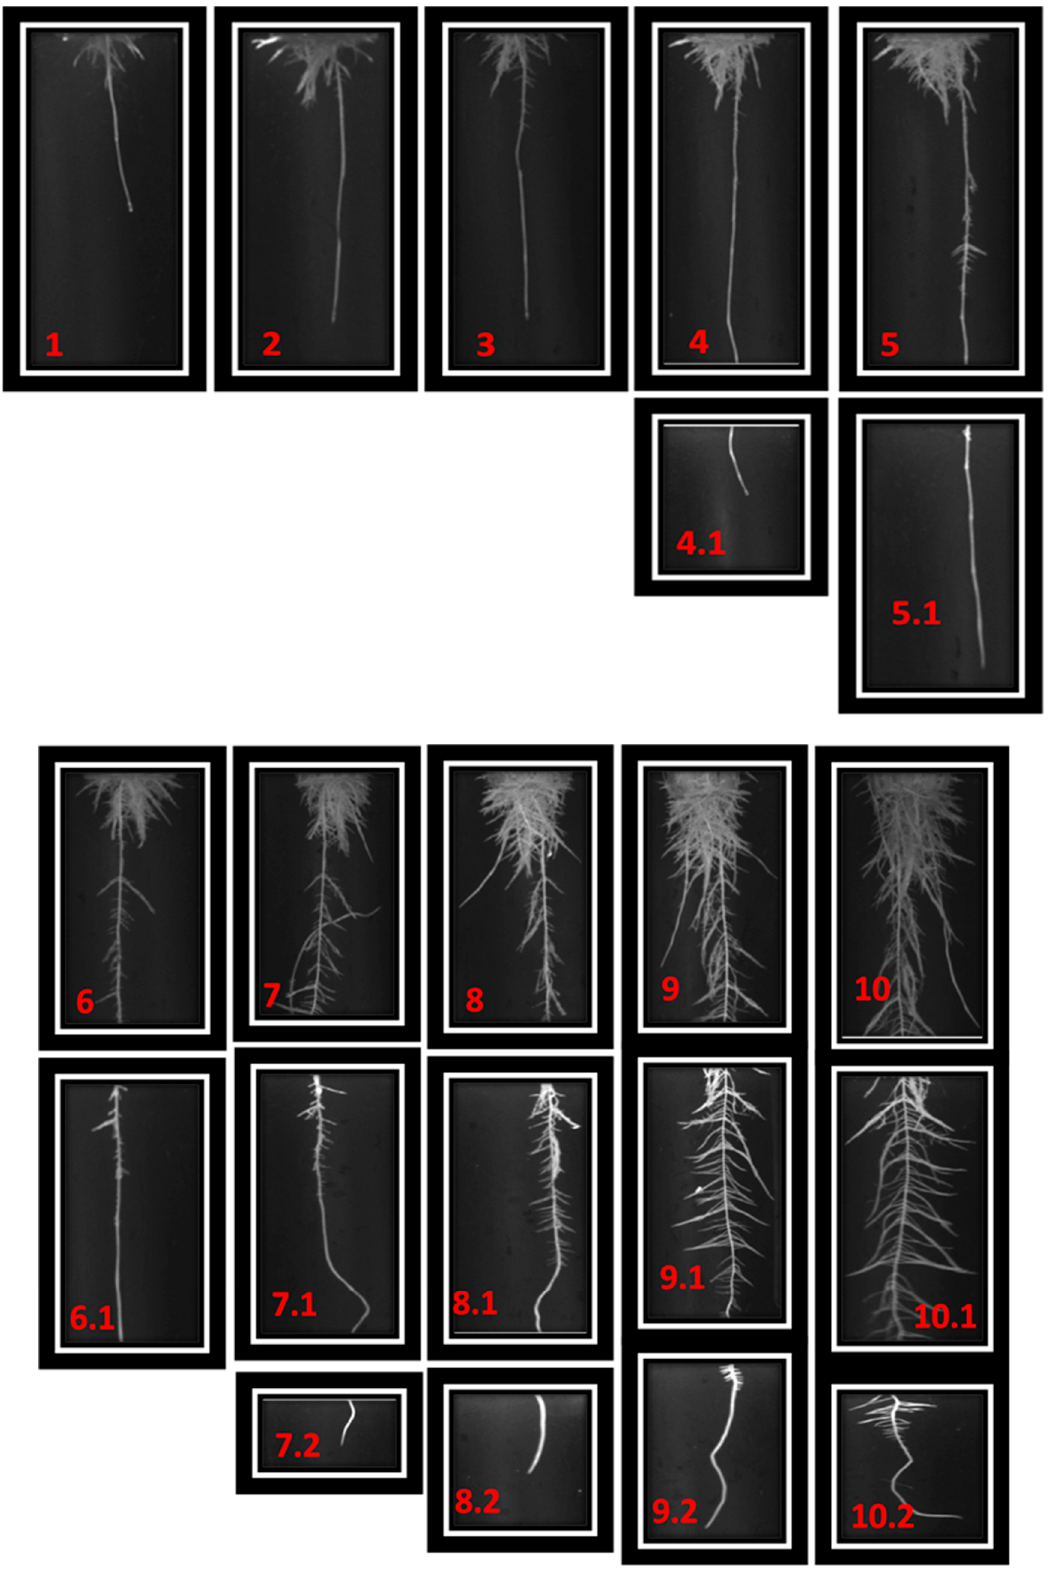
Figure 7. NIR image samples of lettuce RSA for the ten capturing sessions. The annotated first and second number represent the capturing session number and the session image number, respec- tively.